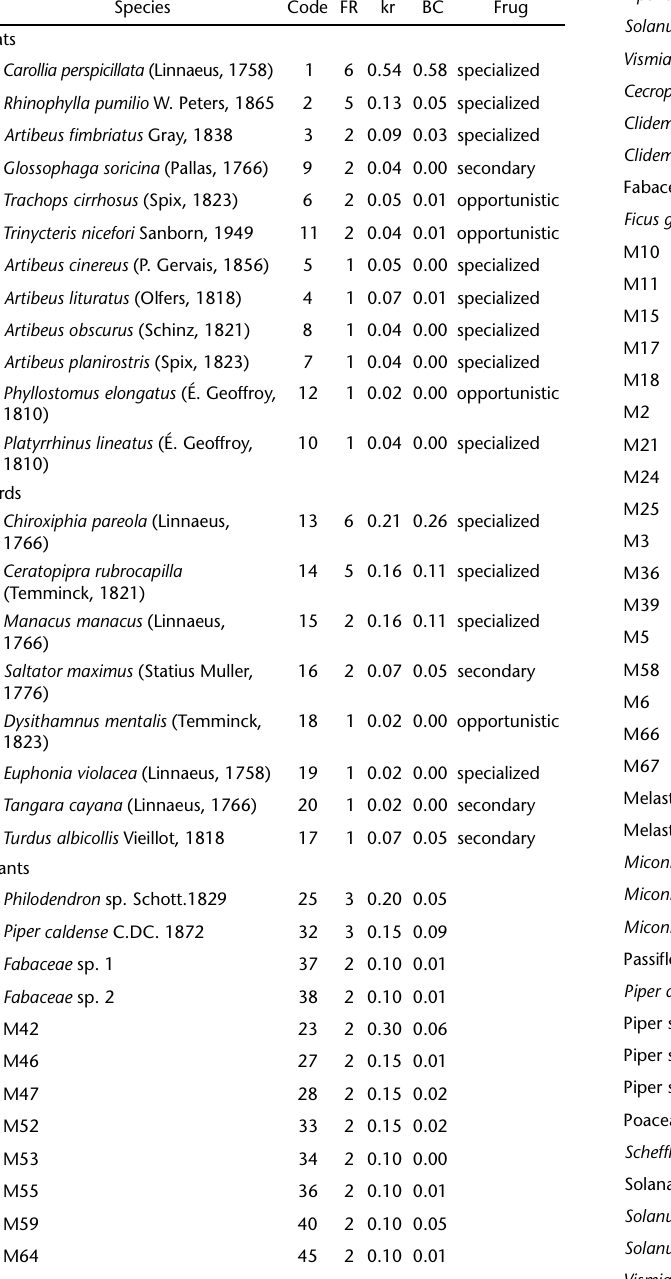
Table II. The studied species of bats, birds, and plants showed a large variation in their ecological functional roles in the mixed seed dispersal network form the Coimbra Forest, northeastern Brazil. Specialized frugivores reached the highest values of network functional role (FR), degree centrality (kr), and betweenness centrality (BC). The codes presented after the species’ names are the same used in Fig.